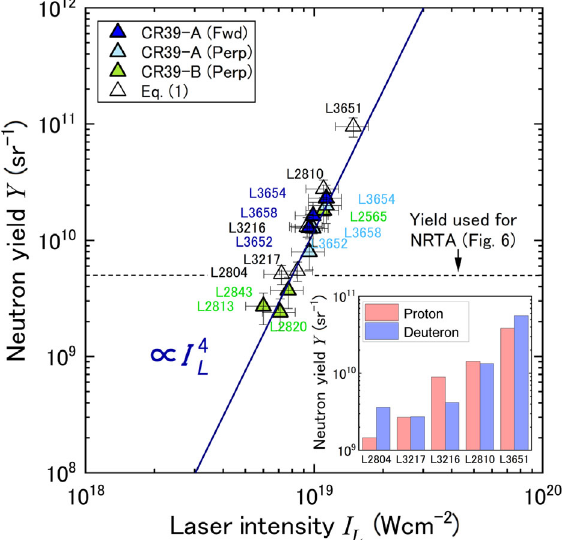
FIG. 4. Neutron yield Y per steradian as a function of the laser intensity I L . The present results are shown as the colored triangles: dark blue by the CR39-A close to 0°, sky blue by the CR39-A close to 90°, and green by the CR39-B. The open triangles show the yields evaluated from the data of the ions in Figs. 1 and 2. The inset shows the contribution to the neutron generation by protons (red) and deuterons (blue) evaluated from the ion data by using the scaling model [Eq. (3)].